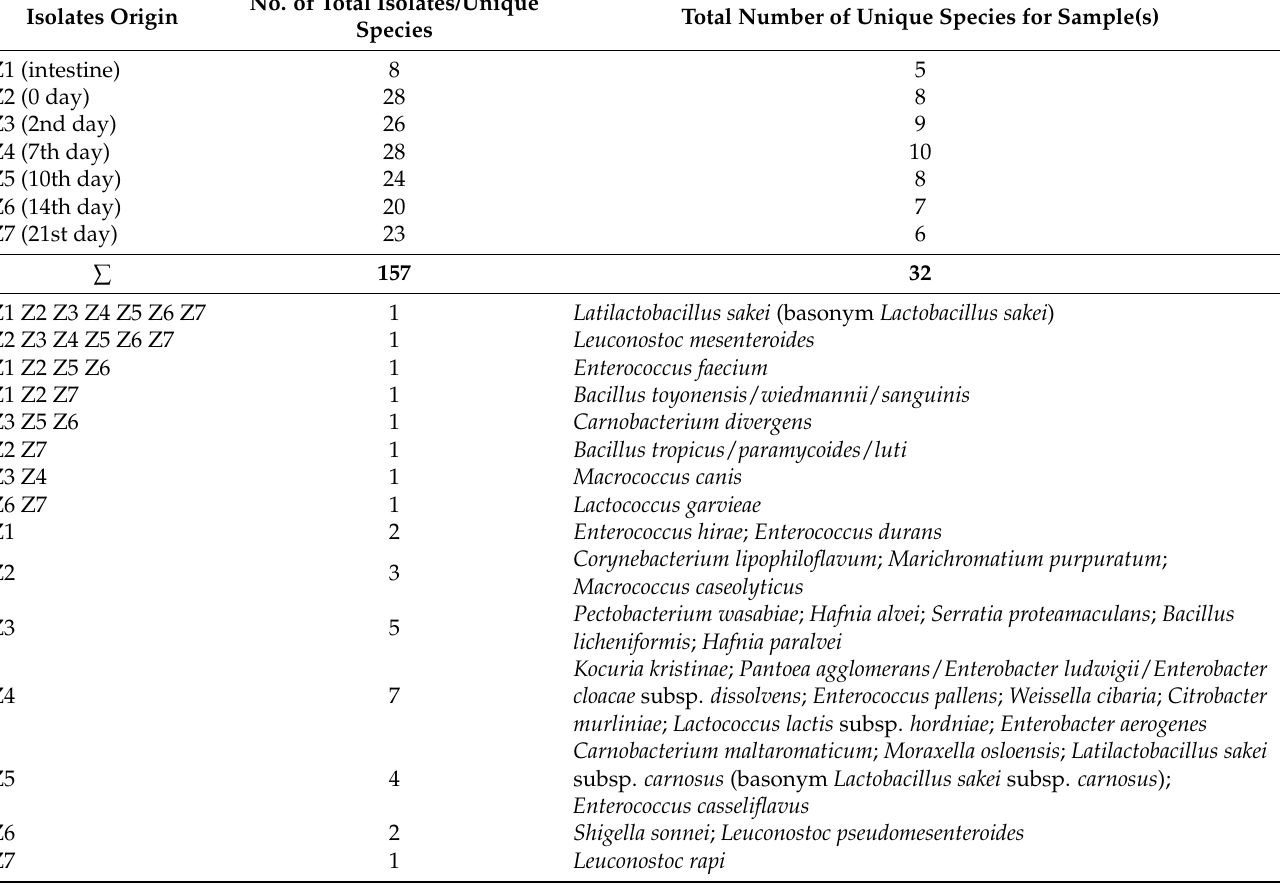
Table 2. Common and unique species diversity within the analyzed intestine and sausage samples during different time points of ripening by culturable